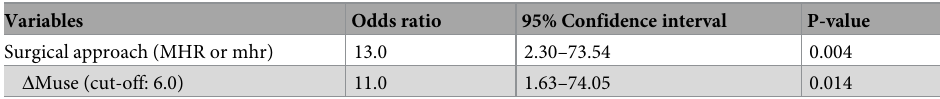
Table 4. Multivariate logistic regression analysis of factors associated with Δ